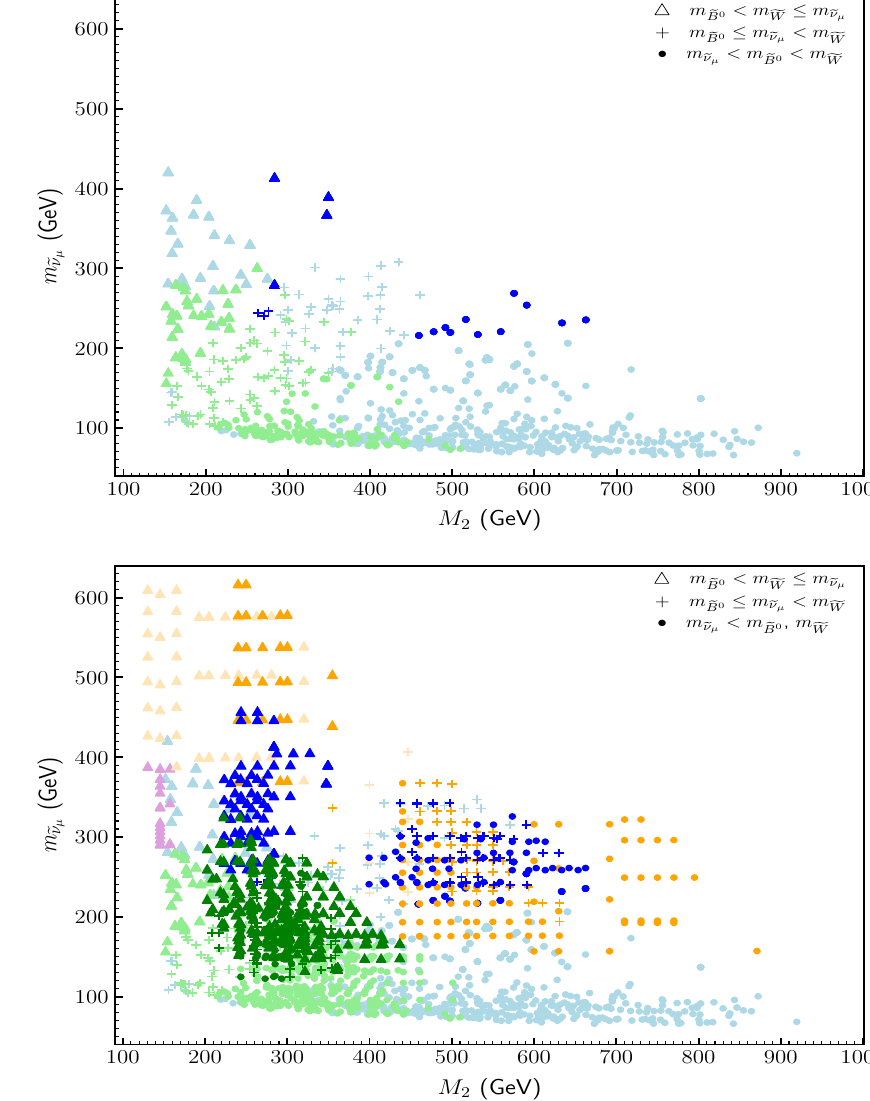
Fig. 13 The same as in Fig. 9, but without showing the red points which are not within the 2 σ cut on (cid:3) a μ . The light-green and light-blue colors indicate points that are excluded by LHC searches